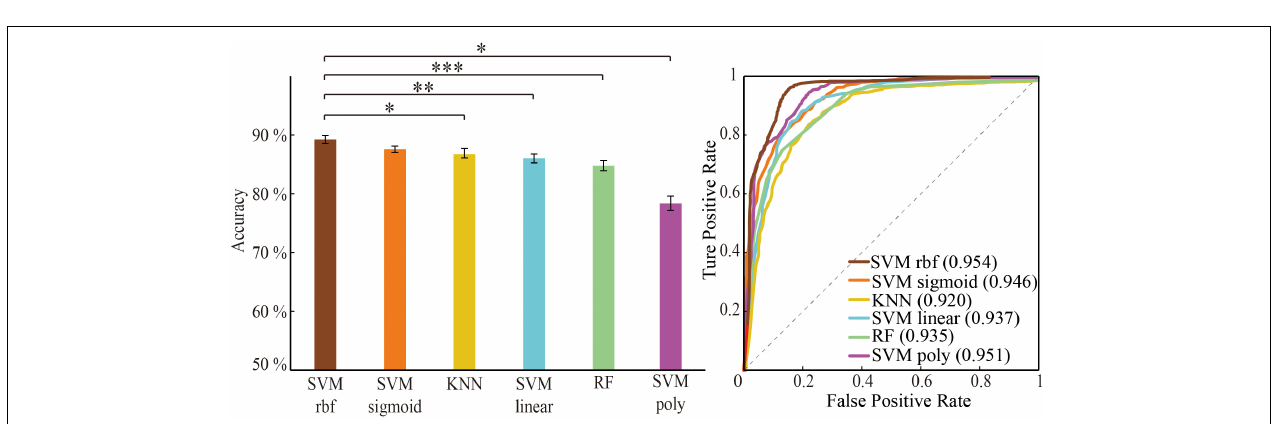
FIGURE 4 | Classification performance comparison between different algorithm through optimal feature set. Classification performance including mean accuracy (mean ± std; ∗ p < 0.05, ∗∗ p < 0.005, and ∗∗∗ p < 0.0005; ranksum test with Bonferroni correction) and AUC of randomly 100 times hold-out method.